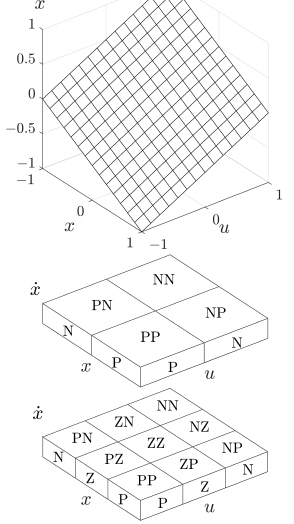
Figure 4. First-order inference map.